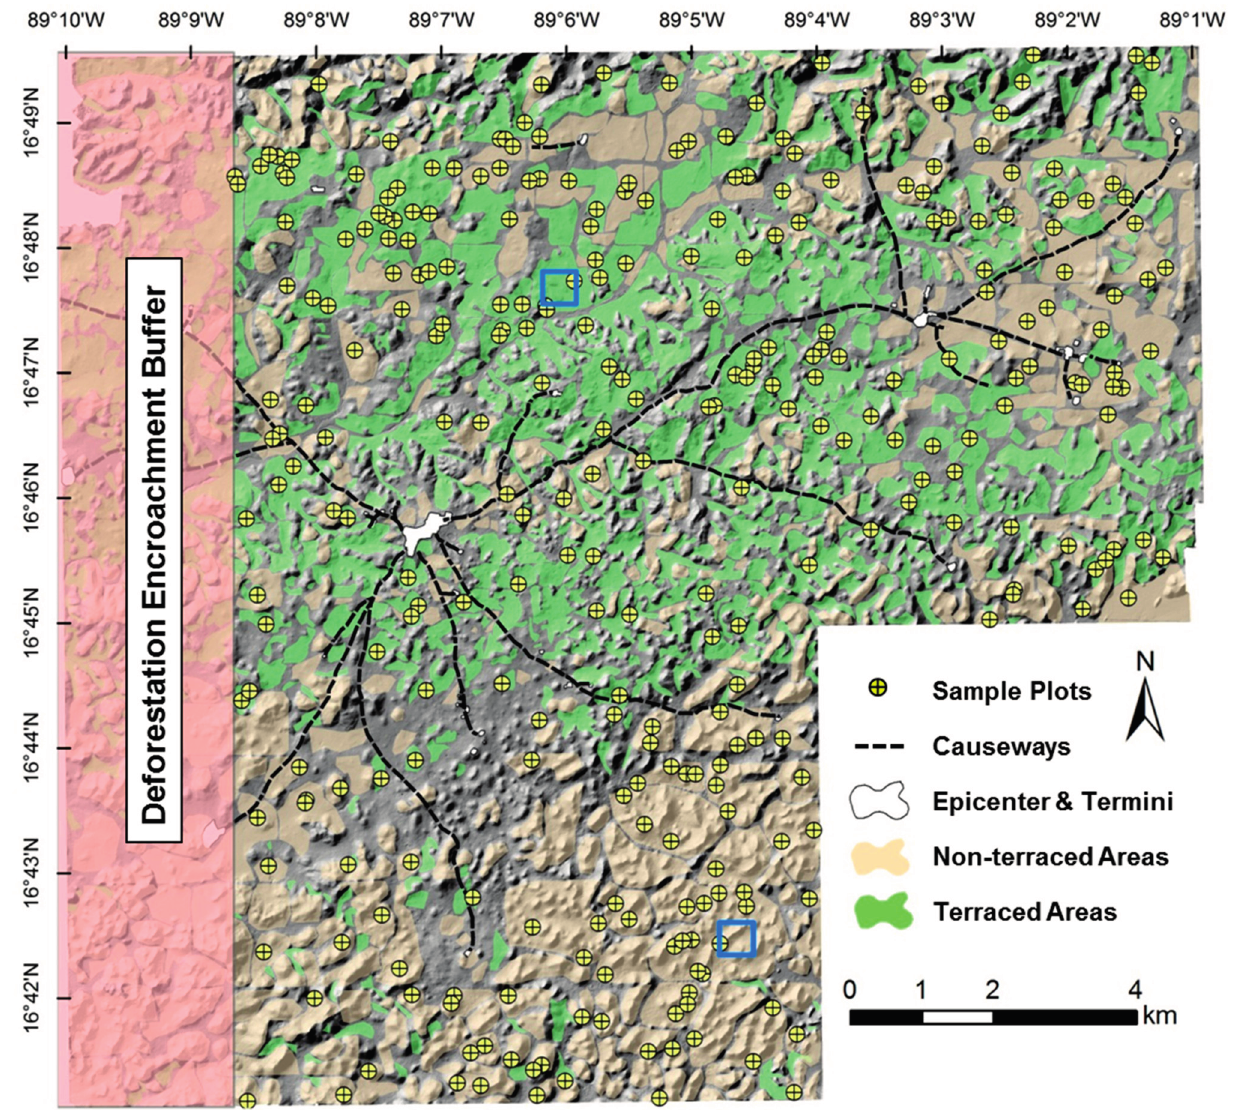
Figure 2. Hillshaded DEM of the Caracol study site with 300 sample plot locations randomly distributed across terraced and non-terraced areas. Samples, which were stratified by land use type (terrace and non-terrace) and by slope (low, medium, high), were not collected near the Guatemala border, where there is ongoing deforestation (shown in